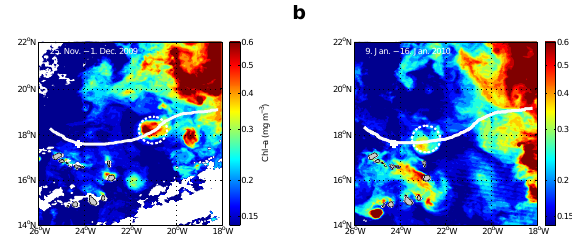
Figure 5. Surface chlorophyll concentration of the CVOO2010 an- ticyclone at two life stages approximately 2 months (a) and 1 month (b) before the centre of the anticyclone crossed the CVOO mooring. The SLA-derived track of the anticyclone centre (see Fig. 1) and the approximate diameter (130km) are shown for reference. The white plus sign marks the CVOO